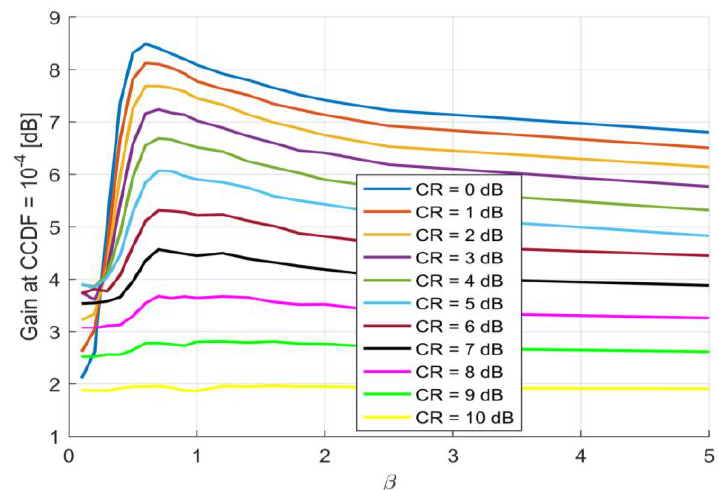
Figure 11. PC-OFDM 64-QAM with variable CRs and smoothness.